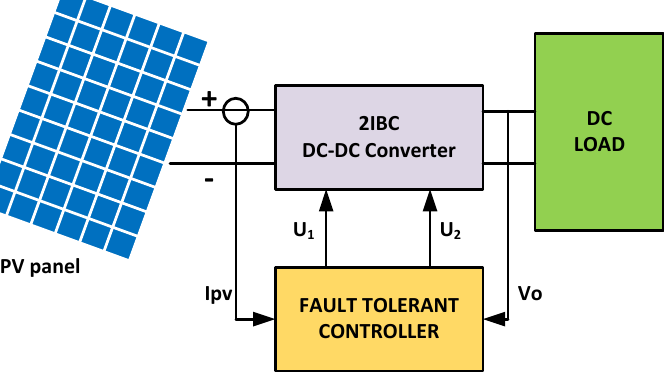
Figure 4. Functional diagram of the control approach.